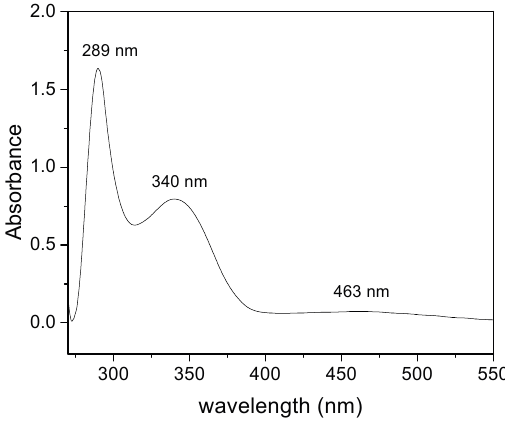
Figure 6. Absorption spectra of the ( III ) and ( IV ) respectively.